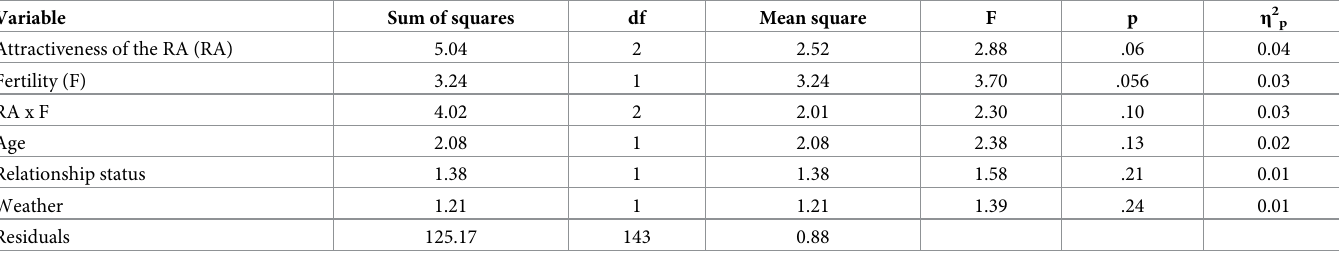
Table 3. The effects of the attractiveness of the research assistant, fertility, research assistant x fertility interaction, controlling for age, relationship status, and weather. Variable Sum of squares Attractiveness of the RA (RA) Fertility